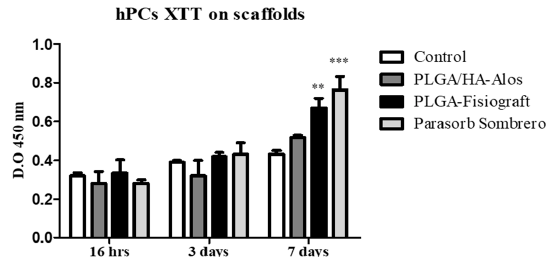
Figure 1. XTT test on hPC cells growth in contact or not with chips of PLGA/HA-Alos, PLGA-Fisiograft and PARASORB Sombrero at 16 h, 3 and 7 days of culture in proliferative medium. **: p < 0.01, ***: p < 0.001 for PLGA/HA-Fisiograft and PARASORB Sombrero versus the control.